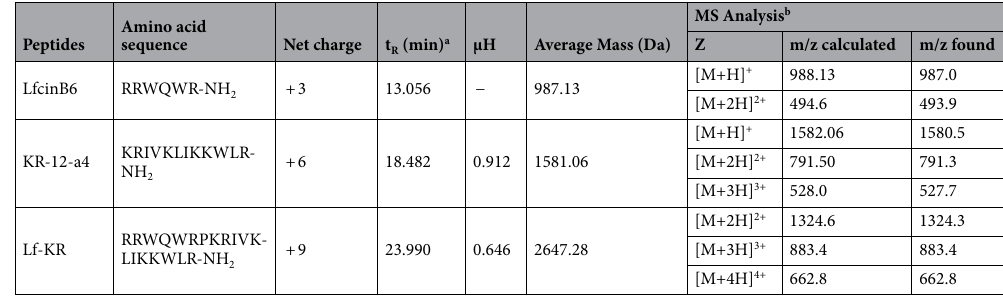
Table 1. Amino acid sequence and physicochemical properties of LfcinB6, KR-12-a4 and Lf-KR. a Retention times (t R ) were determined by analytical RP-HPLC on a C 18 column (5 mm; 4.6 mm × 250 mm; Vydac) using a gradient of buffer B (0.05% TFA in CH 3 CN/H 2 O 90:10 v/v) in buffer A (0.05%TFA in H 2 O) for 60 min with a flow rate of 1.0 mL/min. b μH: Hydrophobic moment. c Molecular masses were determined by electrospray ionization mass spectrometry (ESI–MS). z: ion charge, m/z: mass-to-charge